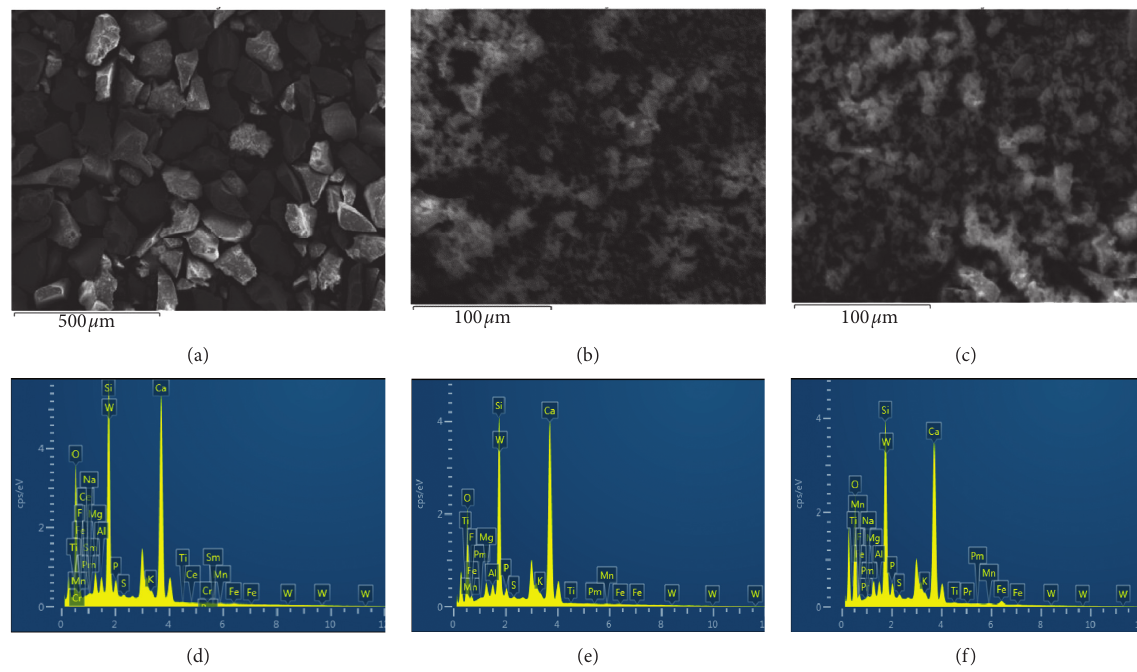
Figure 2: SEM images and EDX spectra of YPS samples. YPS0 (a, d); YPS1 (b, e); YPS2 (c,